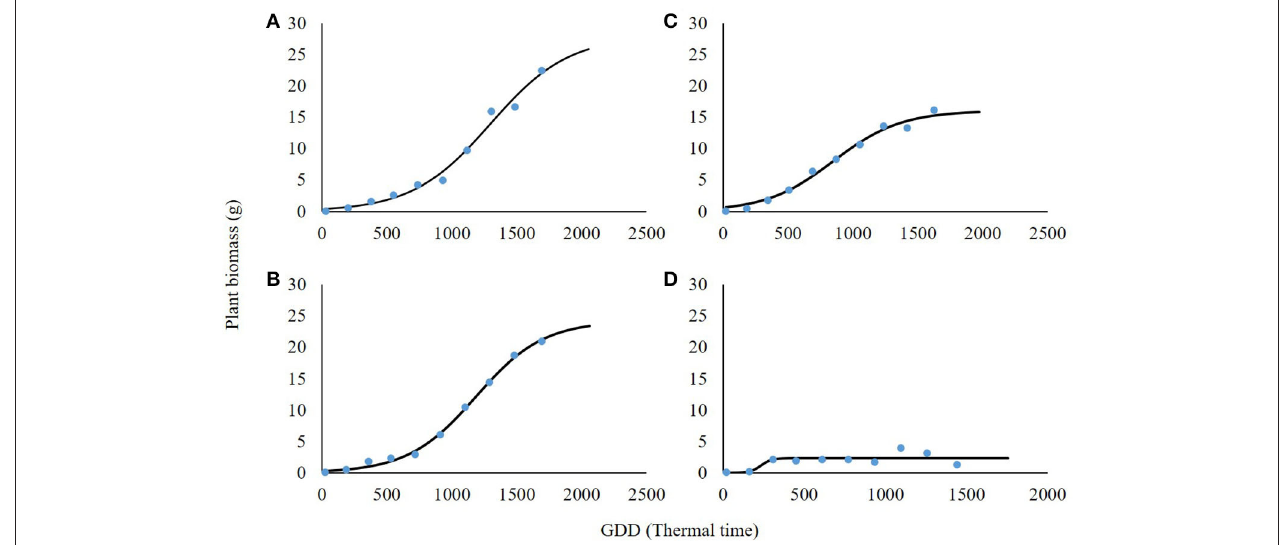
FIGURE 5 | Effect of shade levels (0, 30, 60, and 90%; A–D , respectively) on final shoot biomass of Parthenium hysterophorus . The coefficient for non-linear regressions is given in Table 3 .